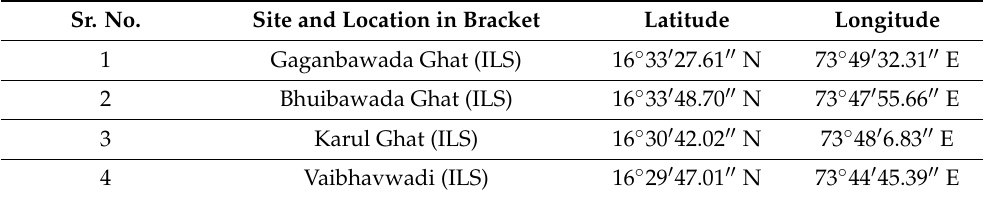
Table 6. Landslide-prone sites: Sindhudurg-Goa subarea. The words windward, ILS and DLS indicate the locations of LS sites on the windward, immediate leeward and distant leeward sides, of the WG mountains,